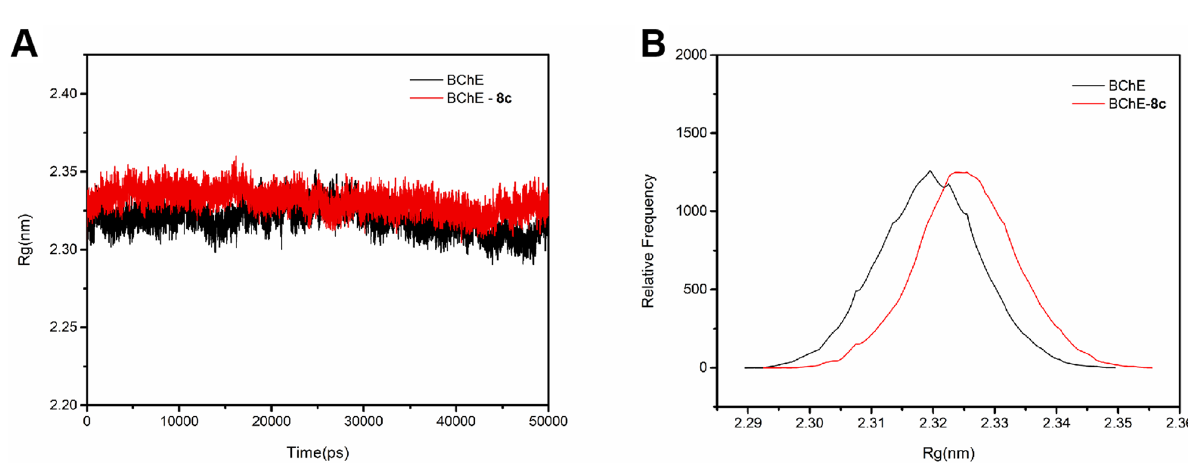
Figure 4. The RMSD ( A ) and RMSF ( B ) of 8c with BChE.